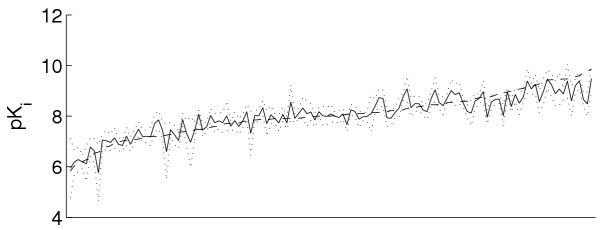
External prediction for alpha data set. External predictions for alpha data set sorted according to growing values of pKi. The figure shows the experimental pKi values (dashed line) and the mean value of the predicted pKi values (solid line) with a 95 % confidence interval (dotted lines). The predictions shown in the figure are from the PLS modelling after variable selection using PLSfilter.